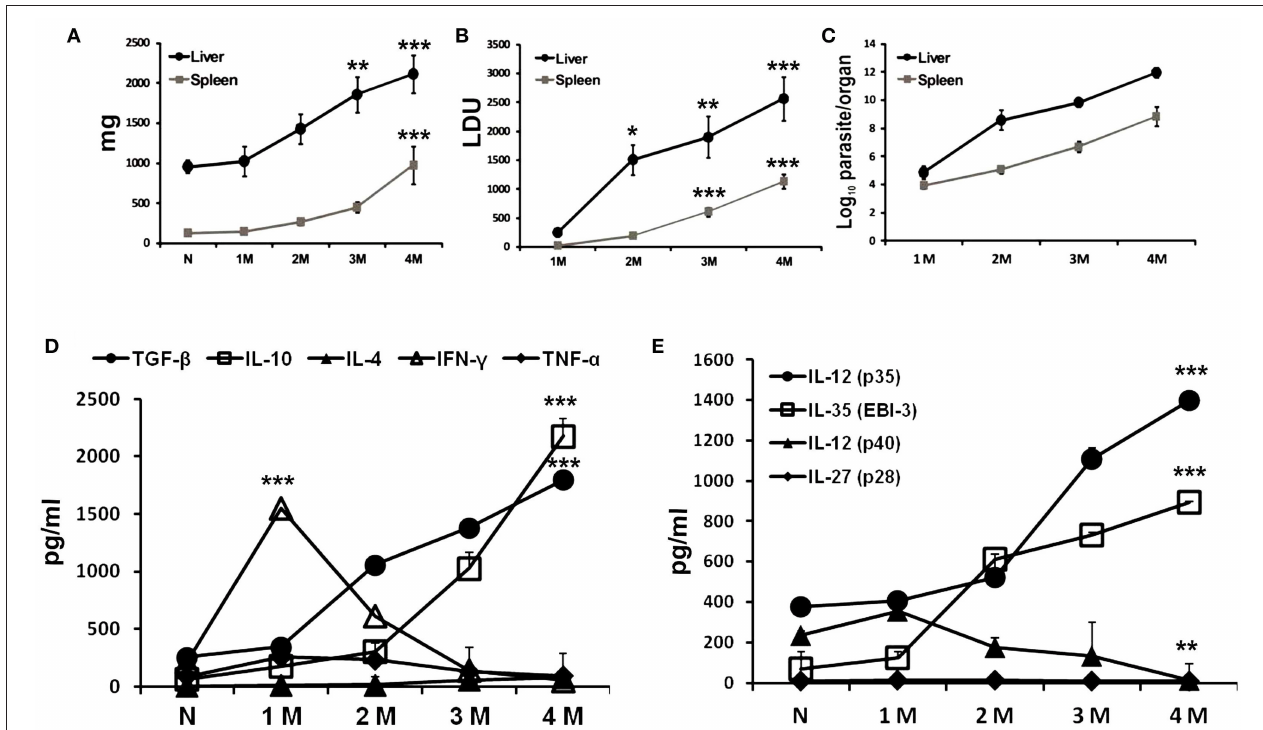
FIGURE 1 | Progressive L. donovani infection synchronized with immuno-suppression in BALB/c mice. BALB/c mice, infected i.v. with 2.5 × 10 7 L. donovani amastigotes, were sacrificed at indicated times post infection. Total organ weights of liver and spleen (A) as well as their parasite burden were determined by LDU (B) and LDA (C) . Cytokines profile of LAg (10 µ g/ml) stimulated culture supernatants of splenocytes obtained from naïve and infected mice were obtained for IFN- γ , TNF- α , IL-4, IL-10, and TGF- β (D) , and the subunit chains of IL-12 family IL-12 (p35), IL-35 (EBI-3), IL-12 (p40), and IL-27 (p28) (E) by ELISA. Data expressed as means ± SE for six mice per group are representative of at least three independent experiments with similar results. * P < 0.05; ** P < 0.01; *** P < 0.001 as assessed by one-way ANOVA and Tukey’s multiple comparison tests.